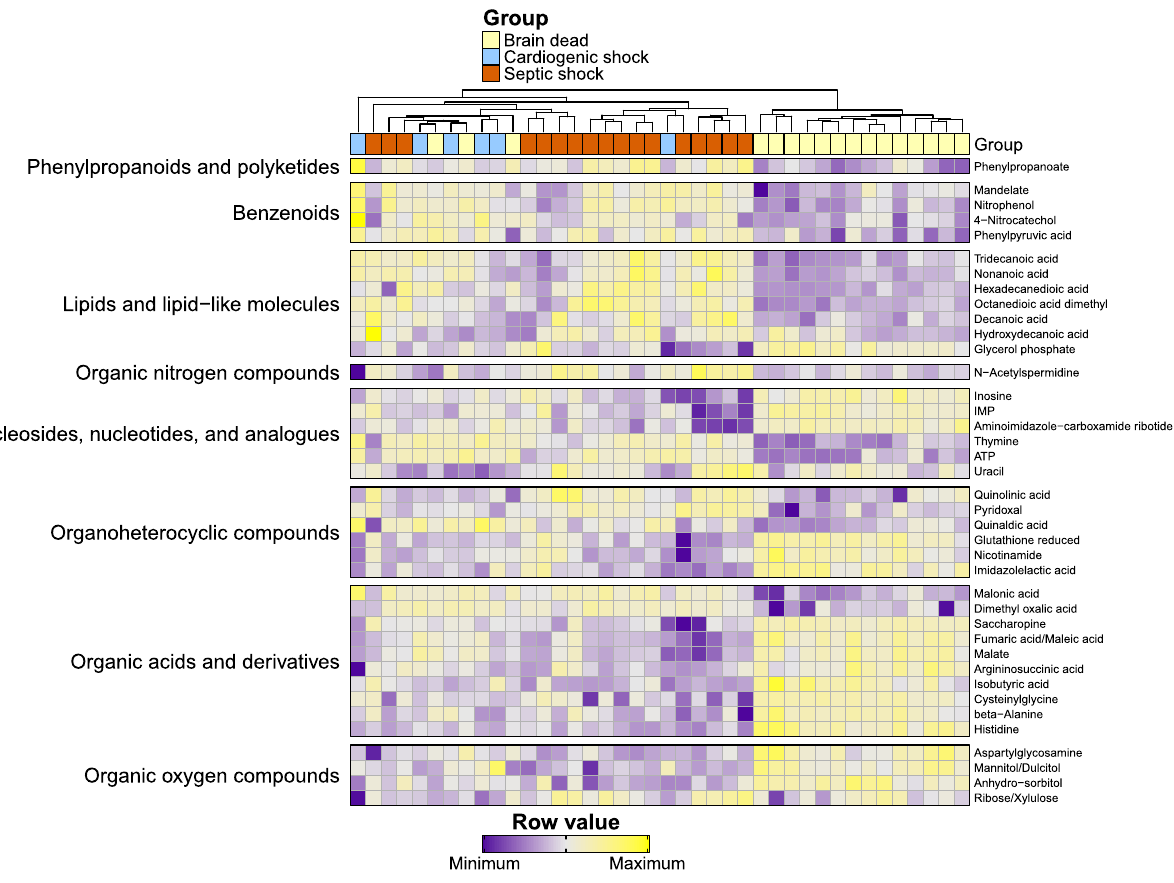
Figure 3. Heat map of the differentially abundant metabolites. Each row represents a metabolite, each column a patient color-coded according to its group. The overlying dendrogram is a graphical representation of patient similarity assessed by the euclidean distance: patients in the same cluster are more similar than patients in two separate clusters. The relative intensities were scaled by rows. Some samples were discarded due to quality checks. N = 40 patients analyzed for the metabolomics (Septic shock n = 17, cardiogenic shock n = 6, brain dead n = 17).